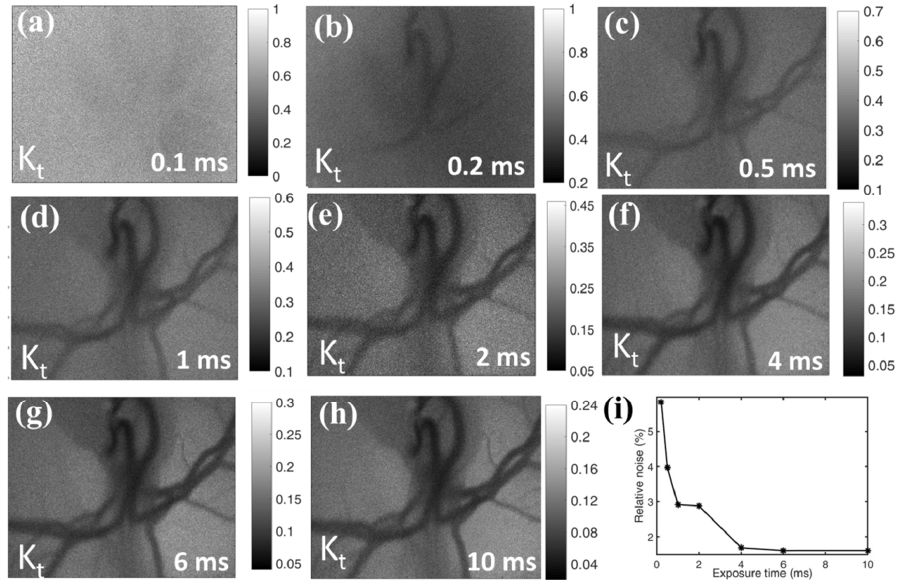
Figure 4. ( a – h ) Temporal laser speckle contrast image of a chick embryo (day 3) obtained with the SI-LSCI at different exposure durations 0.1, 0.2, 0.5, 1, 2, 4, 6, and 10 ms, respectively. ( i ) Relative noise in the speckle contrast image σ K /K at different exposure times.